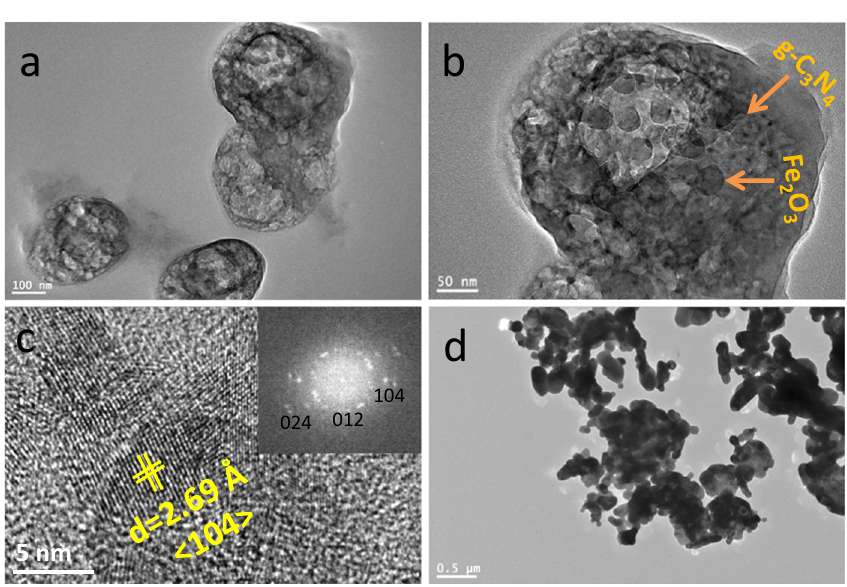
Figure 5. ( a , b ) TEM, and ( c ) HRTEM of mesoporous α -Fe 2 O 3 @g-C 3 N 4 -NCs. ( d ) TEM of α -Fe 2 O 3 -NPs. Inset of Fig. 4c shows electron diffraction of mesoporous α -Fe 2 O 3 @g-C 3 N 4